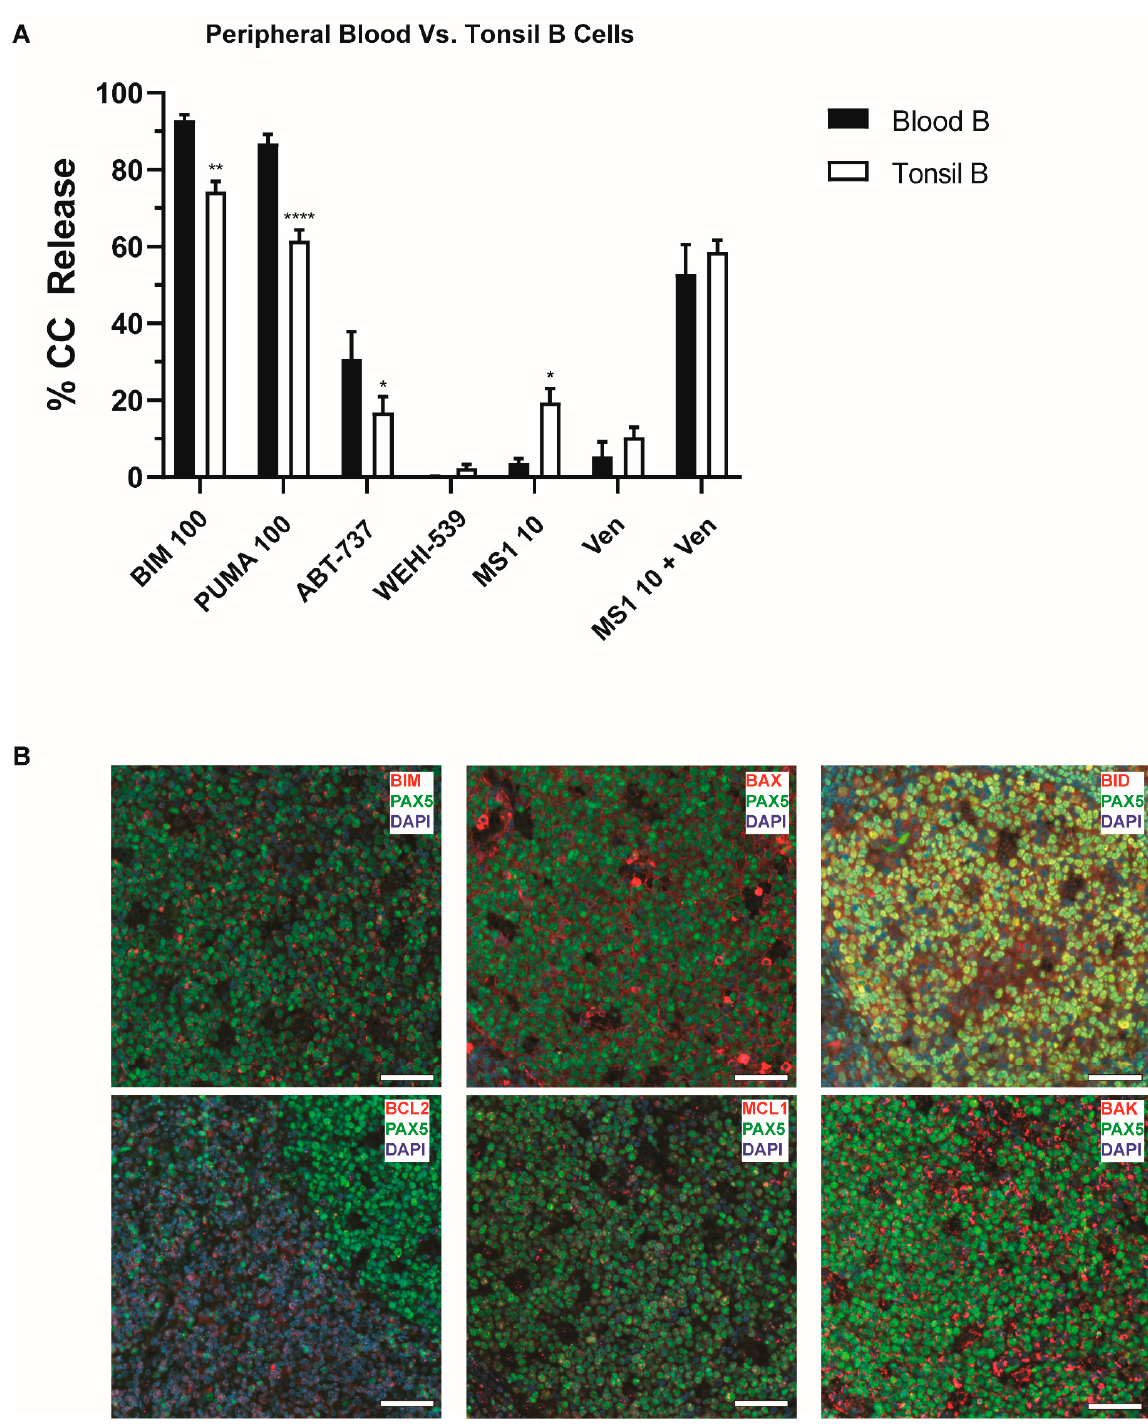
Figure 2. BH3 profiling of peripheral blood (PB) and tonsil B cells. ( A ) The percentage of cells undergoing cytochrome c release is displayed on the y -axis according to different cell subsets identified on the x -axis. Shown is the comparison of frozen B lymphocytes from tonsils and peripheral blood. Tonsillar B cells have lower responses to BIM and PUMA, while showing increased responses to MS1. Bars represent the mean ± standard error of the mean (SEM). Analysis was carried out using a 2-way ANOVA comparing peptide exposure or subtype with cytochrome c release. * p < 0.05, ** p < 0.01, **** p < 0.0001. ( B ) Representative merged immunofluorescence (IF) images of normal tonsil. Images were taken on a 20 × objective highlighting staining of DAPI (blue), PAX5 (green, AF594) and the protein of interest (red, AF647). Scale bars represent 50 µ m. Pro-apoptotic proteins are expressed in normal germinal center (GC) cells, along with MCL1. BCL2 expression is confined to the edges of the GC follicle and PAX5 negative